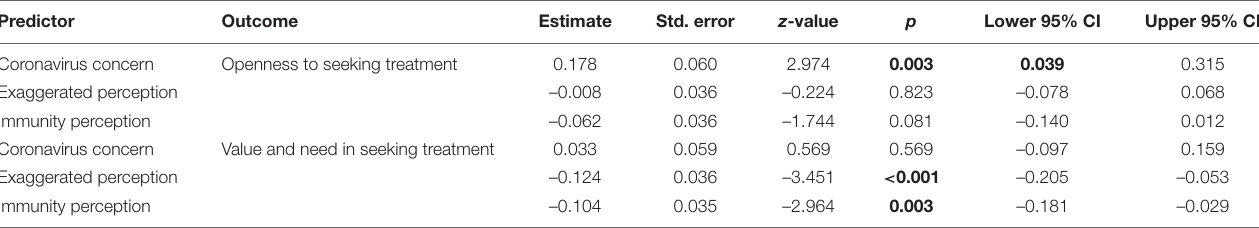
TABLE 6 | Direct effects of CAS-10 subscales over ATSPPH-SF